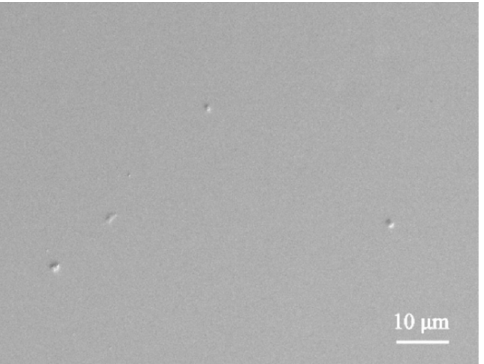
Figure 5. The top − view SEM image of the PDMS/PVDF membranes after treatment with DCB iso- Figure 5. The top-view SEM image of the PDMS/PVDF membranes after treatment with DCB isomers mers (molar ration 1:1) at 60 °C for 5 days. (molar ration 1:1) at 60 ◦ C for 5